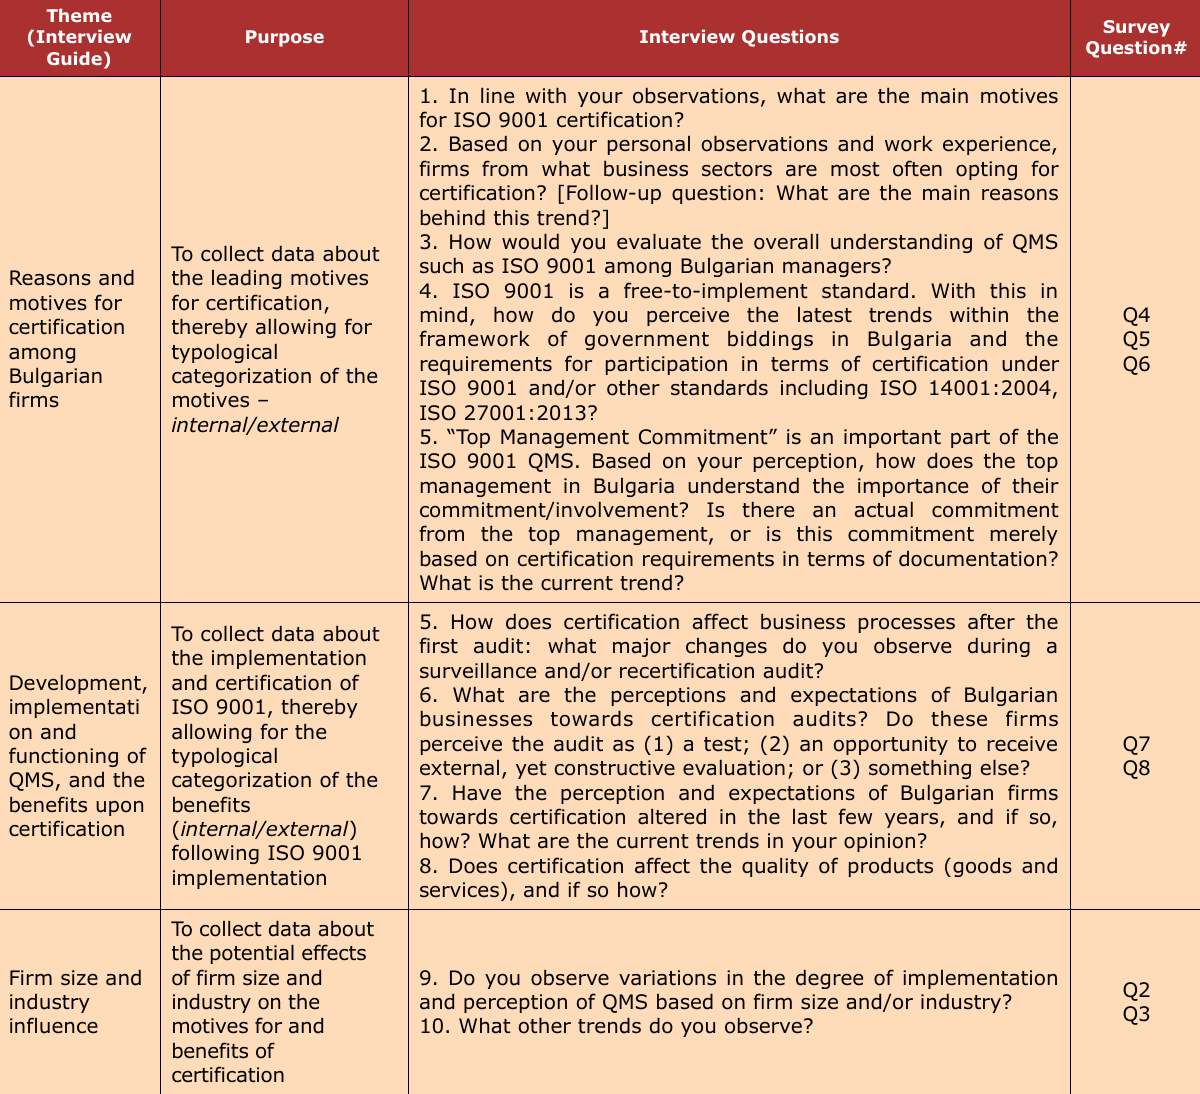
Table 4. Interview Protocol and Framework for Qualitative